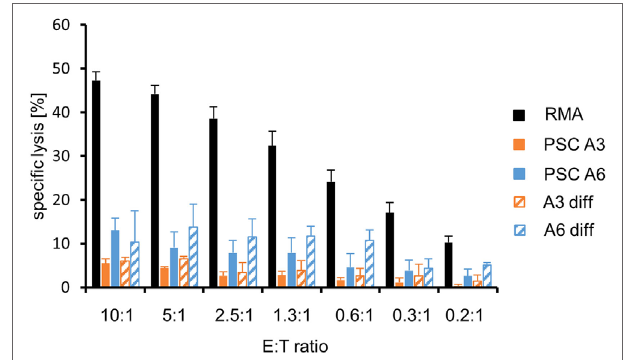
FigUre 6 | Comparison of the killing of parthenogenetic stem cell (PSC) A3, PSC A6, and in vitro -differentiated cells as well as RMA control cells by peptide-specific cytotoxic T lymphocytes from OT-I mice. A summary of means of specific lysis and SEM is shown as determined by 51 Cr-release assays of the target cells RMA ( n = 13), PSC A3 ( n = 4), PSC A6 ( n = 4), differentiated A3 cells ( n = 2), and differentiated A6 cells ( n = 3). The killing has been assayed after pulsing of the target cells with the appropriated peptide